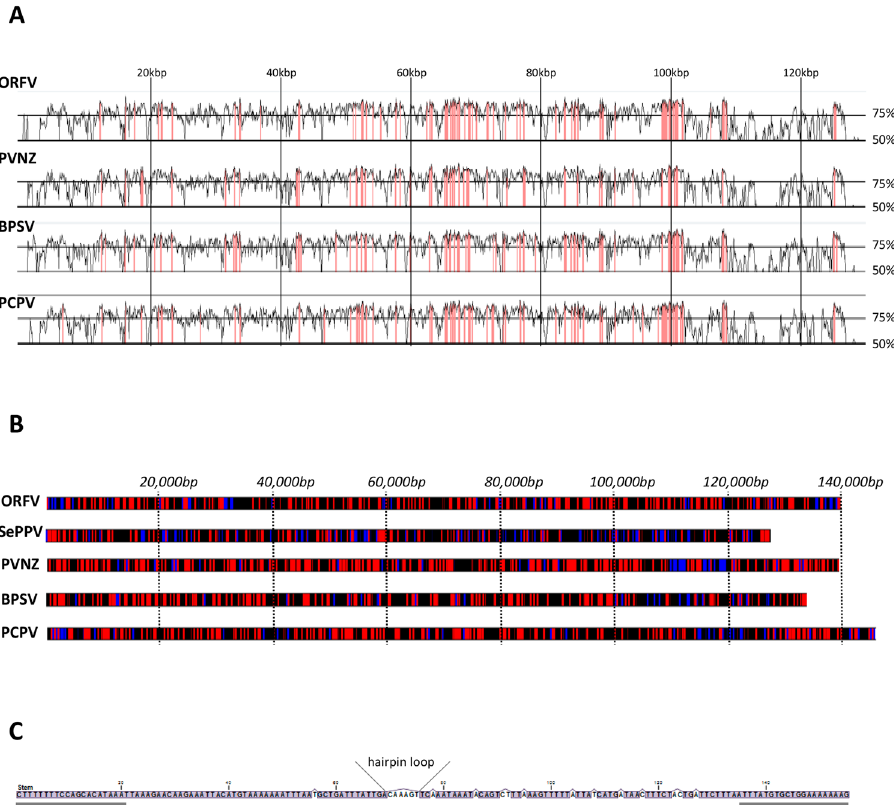
Figure 2. Genome Characterization of the full-length genome seal parapoxvirus sequence. ( A ) Sequence alignment of seal parapoxvirus (KY382358) to all four reference genomes (ORFV: AY386264.1, PVNZ: NC_025963.1, BPSV: NC_005337.1, PCPV: NC_013804.1) in the genus parapoxvirus. The alignment was performed using the global alignment program AVID implemented in VISTA (tool for comparative genomics). Alignments were visualized with VISTA point (Calc Window, bp: 100; Min Cons Width, bp: 100; Cons Identity, %: 90 Minimum Y, %:50). The graph represents percent conservation between the aligned sequences at a